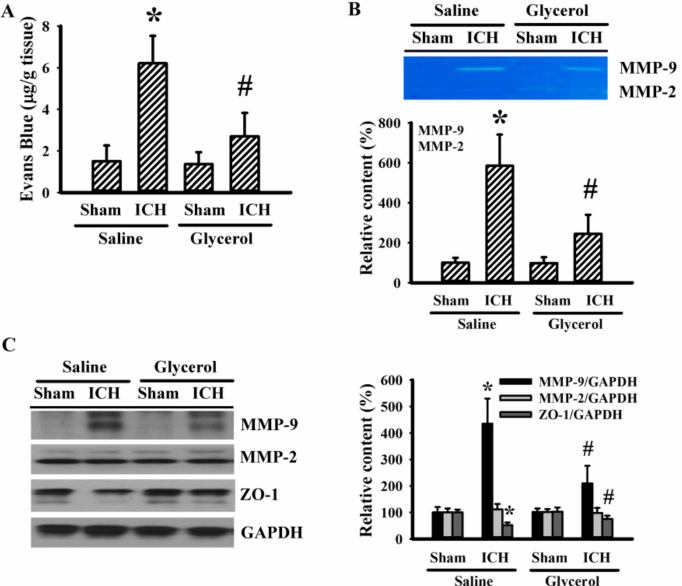
Figure 2. Glycerol alleviated hemorrhagic stroke BBB disruption. ICH and sham rats were intraperi- toneally injected with saline or glycerol and housed for an additional 24 h. ( A ) The contents of Evans blue in the ipsilateral striatal tissues were measured. ( B ) Proteins were extracted from the ipsilateral striatal tissues and subjected to zymography assay. Representative gels and the quantitative data are shown. ( C ) Proteins were extracted from the ipsilateral striatal tissues and subjected to Western blot assay with indicated antibodies. Representative blots and the quantitative data are shown. Specific protein content was normalized with GAPDH. * p < 0.05 vs. sham/saline and # p < 0.05 vs. ICH/saline, n =